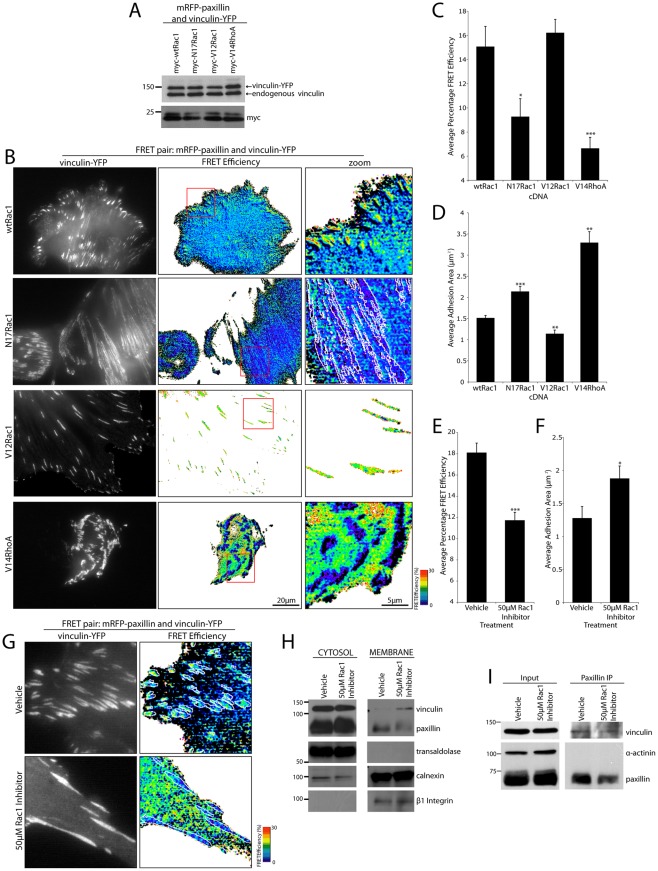
The interaction between paxillin and vinculin in adhesions is spatially regulated by the activity of the RhoGTPases.(A) Western blot of vinculin-YFP and myc-tagged Rac1 and RhoA mutant expression in NIH 3T3 cells used for FRET analyses. (B) Representative donor (vinculin-YFP) and FRET efficiency images indicating that in the presence of wild type (wt) or active (V12Rac1) Rac1, paxillin and vinculin are within FRET proximity. In contrast, inhibition of Rac1 (N17Rac1) or activation of RhoA (V14RhoA) results in a loss of adhesion-localized FRET. FRET image zooms highlight representative FRET pattern of cells as indicated. (C) Quantitation of average FRET efficiency of mRFP-paxillin and vinculin-YFP in all adhesions of cells expressing activation mutants of Rac1 and RhoA. (D) Adhesion area calculations for cells expressing mRFP-paxillin and vinculin-YFP with indicated Rac1 and RhoA mutants. Expression of the active V12Rac1 mutant promotes the formation of smaller adhesions, while the dominant negative N17Rac1 or active V14RhoA constructs induce an increase in adhesion area. Error bars are standard error of the mean from cells used for FRET calculations. (E) Quantitation of average FRET efficiency of mRFP-paxillin and vinculin-YFP in all adhesions of cells in the presence of vehicle (dH20) or 50 μM Rac1 inhibitor (NSC23766). (F) Quantitation of average adhesion area in cells treated with vehicle or 50 μM Rac1 inhibitor. Error bars are standard error of the mean and values calculated from all adhesions from a minimum of 10 cells from 3 individual experiments. * = p<0.05, ** = p<0.005 and *** = p<0.0005. (G) Representative images of NIH 3T3 cells displaying increased vinculin-YFP cytosol/membrane localization indicating positive FRET in both adhesion contacts and areas outside integrin-mediated adhesions. Treatment with 50 μM Rac1 inhibitor decreased FRET in adhesion contacts with cytosolic/membrane FRET still observed. White lines highlight vinculin-YFP-positive adhesion areas. (H) Western blots indicating an increase in endogenous vinculin recruitment to the membrane-enriched fraction of cells treated with 50 μM Rac1 inhibitor. (I) Representative Western blots indicating no effect of the Rac1 inhibitor on the ability of endogenous paxillin and vinculin to coimmunoprecipitate, n = 3 individual experiments.